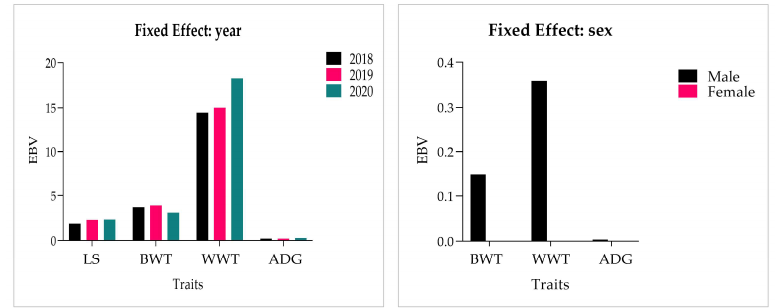
Figure 1. EBV for different traits in fixed effects.